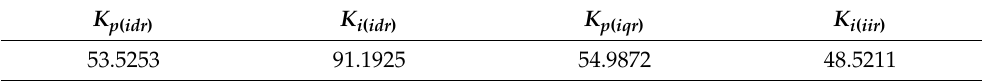
Table 2. PI controller gains for 70% dip.